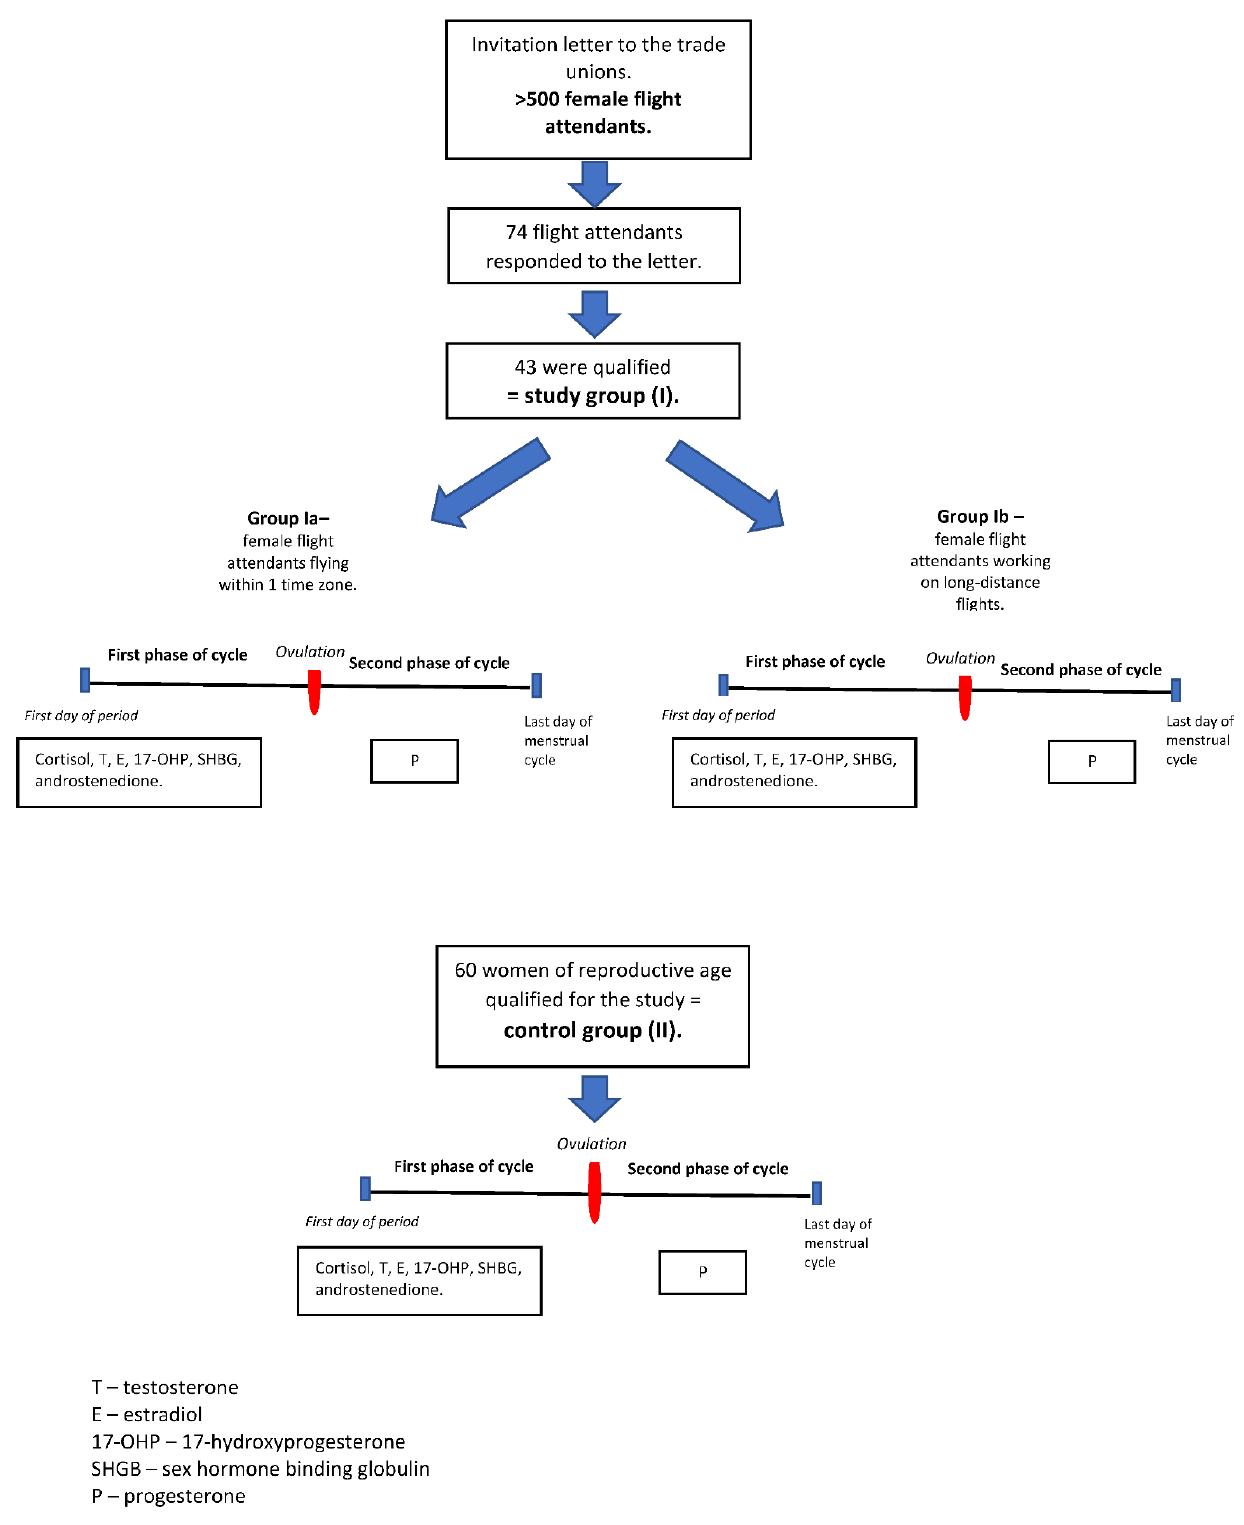
Figure 1. Study design.